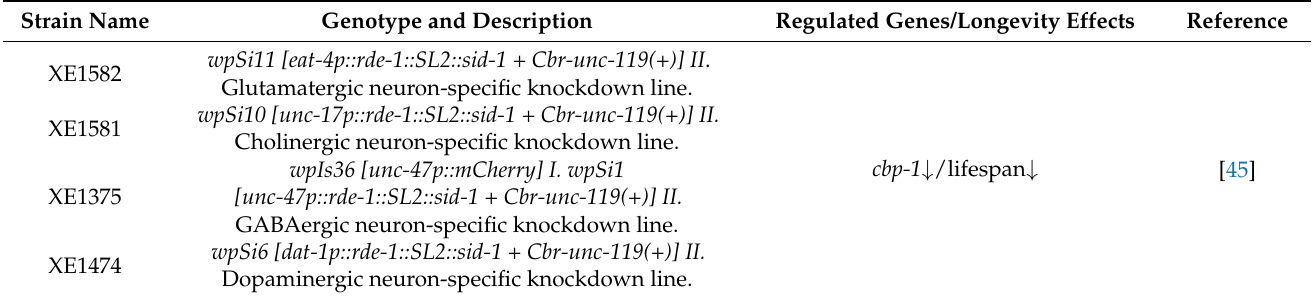
Table 2. Neuron cell-type-specific strain